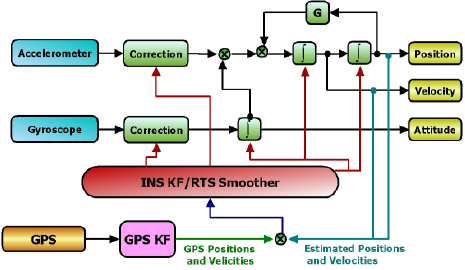
Figure 2 The integration architecture of LC (closed loop)